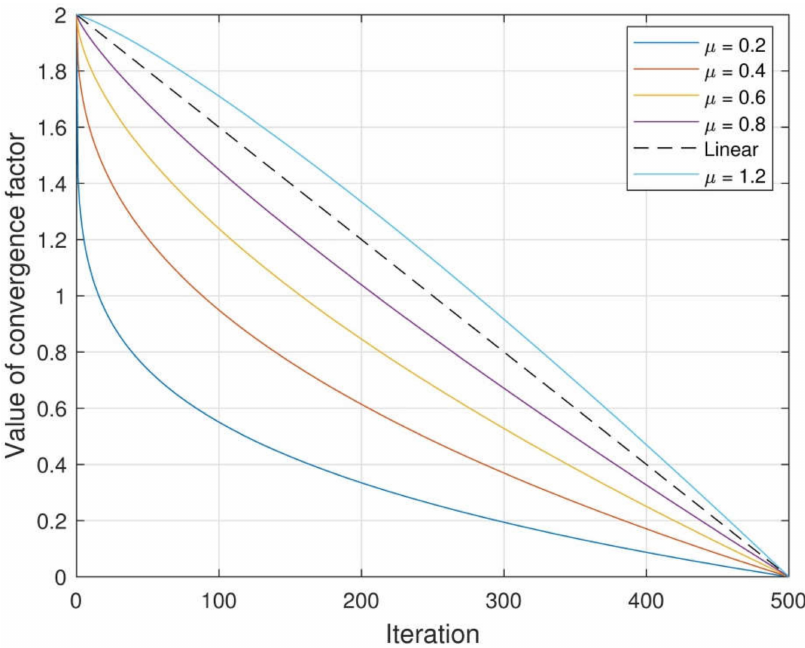
Figure 2. Change curves of nonlinear of parameter a with different µ